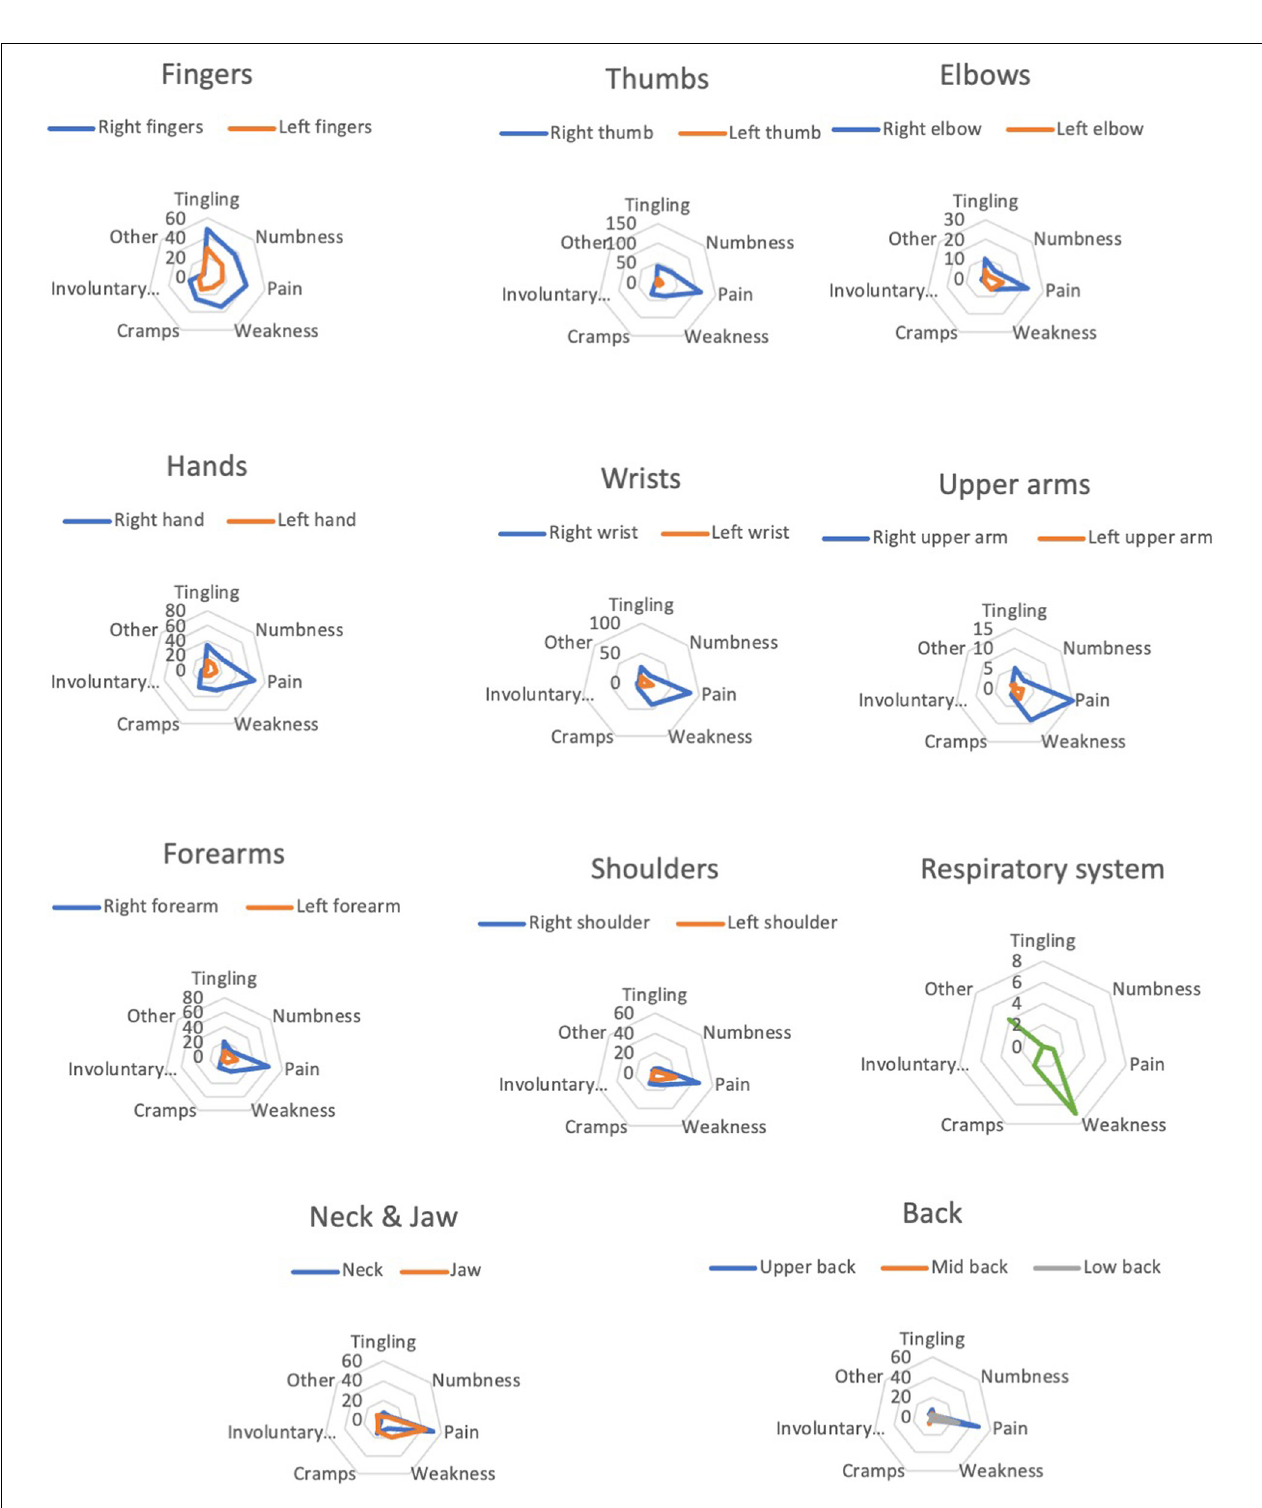
FIGURE 6 | Sensation profiles for each PRMD